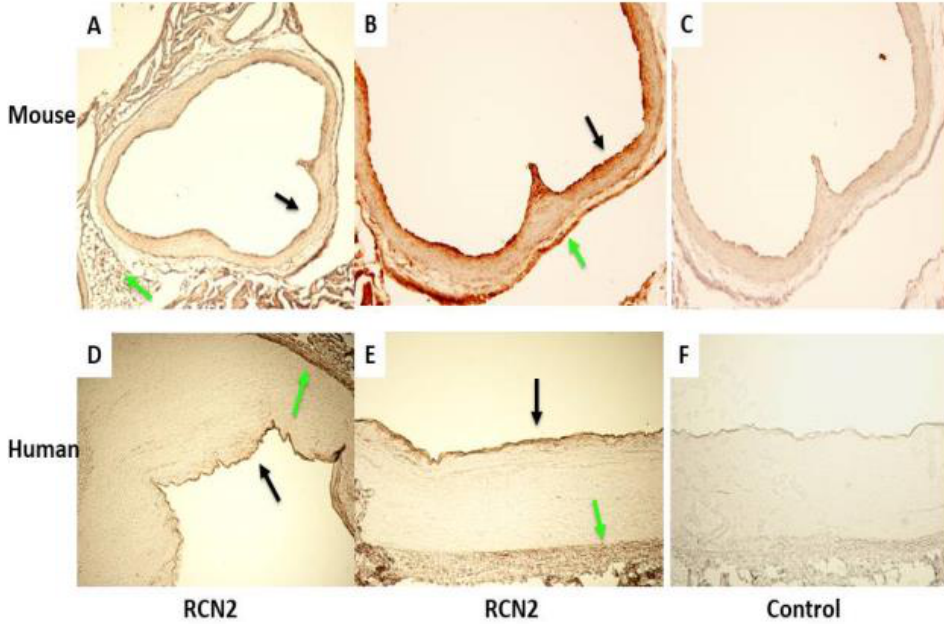
Figure 1. Immunohistochemical detection of reticulocalbin 2 (RCN2) expression in the normal arterial walls of a mouse and a human. Sections were stained with ( A , B , D , E ) or without ( C , F ) the presence of RCN2 antibody. Note strong RCN2 expression in the endothelial layer and adventitia of the artery wall. Original magnifications: × 4 ( A , D ), × 10 ( B , C , E , F ). Black arrows point at stained intima, and green arrows at stained adventitia.